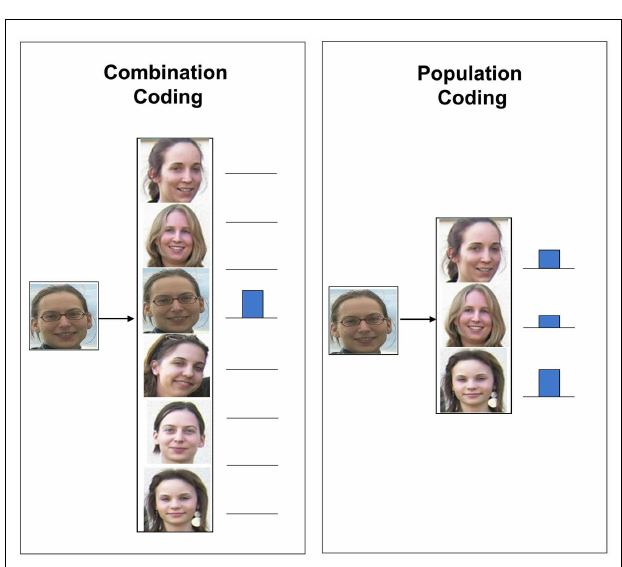
FIGURE 3 | Combination coding vs. population